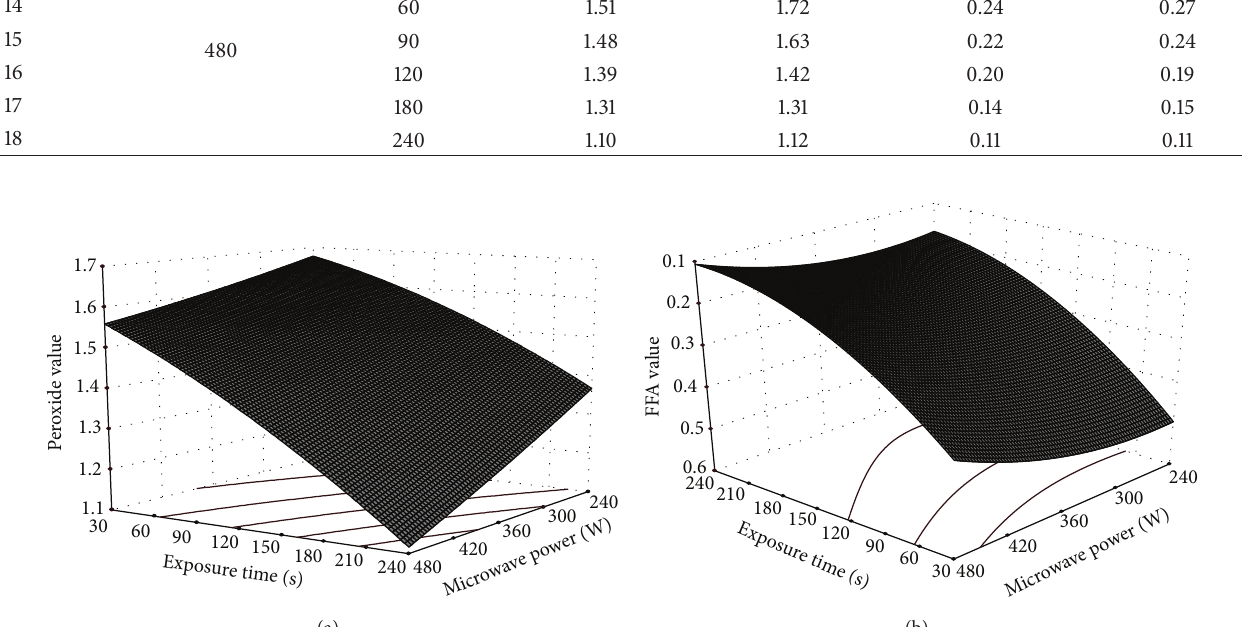
Figure 4: Effect of microwave power and exposure time on (a) PV and (b) FFA values of cashew nuts.